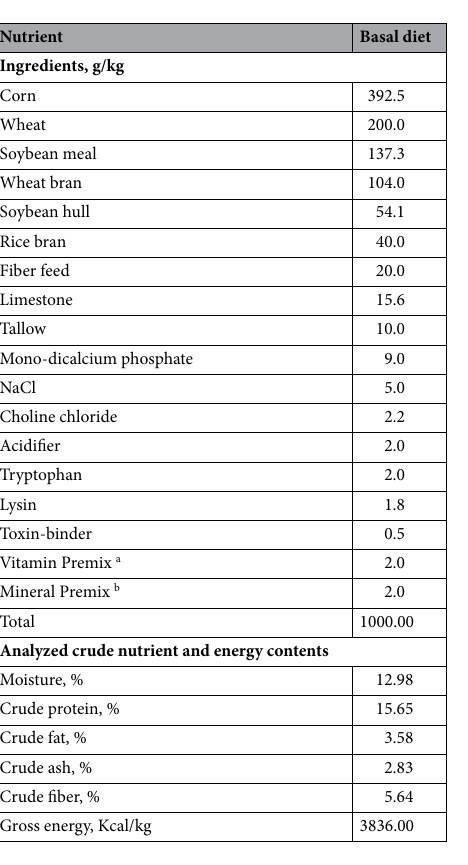
Table 1. Composition, nutrient and energy contents of basal diet for Jeju native pig. a The vitamin premix provided per kg diet: vitamin A, 12,000 IU; vitamin D3, 2,000 IU; vitamin E, 100 IU; vitamin K3, 4.5 mg; vitamin B1, 2 mg; vitamin B2, 7 mg; vitamin B3, 45 mg; pantothenic acid, 30 mg; vitamin B6, 4.5 mg; Biotin, 0.5 mg; Folic acid, 3.5 mg; vitamin B12, 0.03 mg; antioxidant, 6.6 mg. b The mineral premix provided per kg diet: Fe, 150 mg; Zn, 85 mg; Mn, 37 mg; Cu, 11 mg; Co, 2 mg; I, 0.3 mg; Se, 0.15